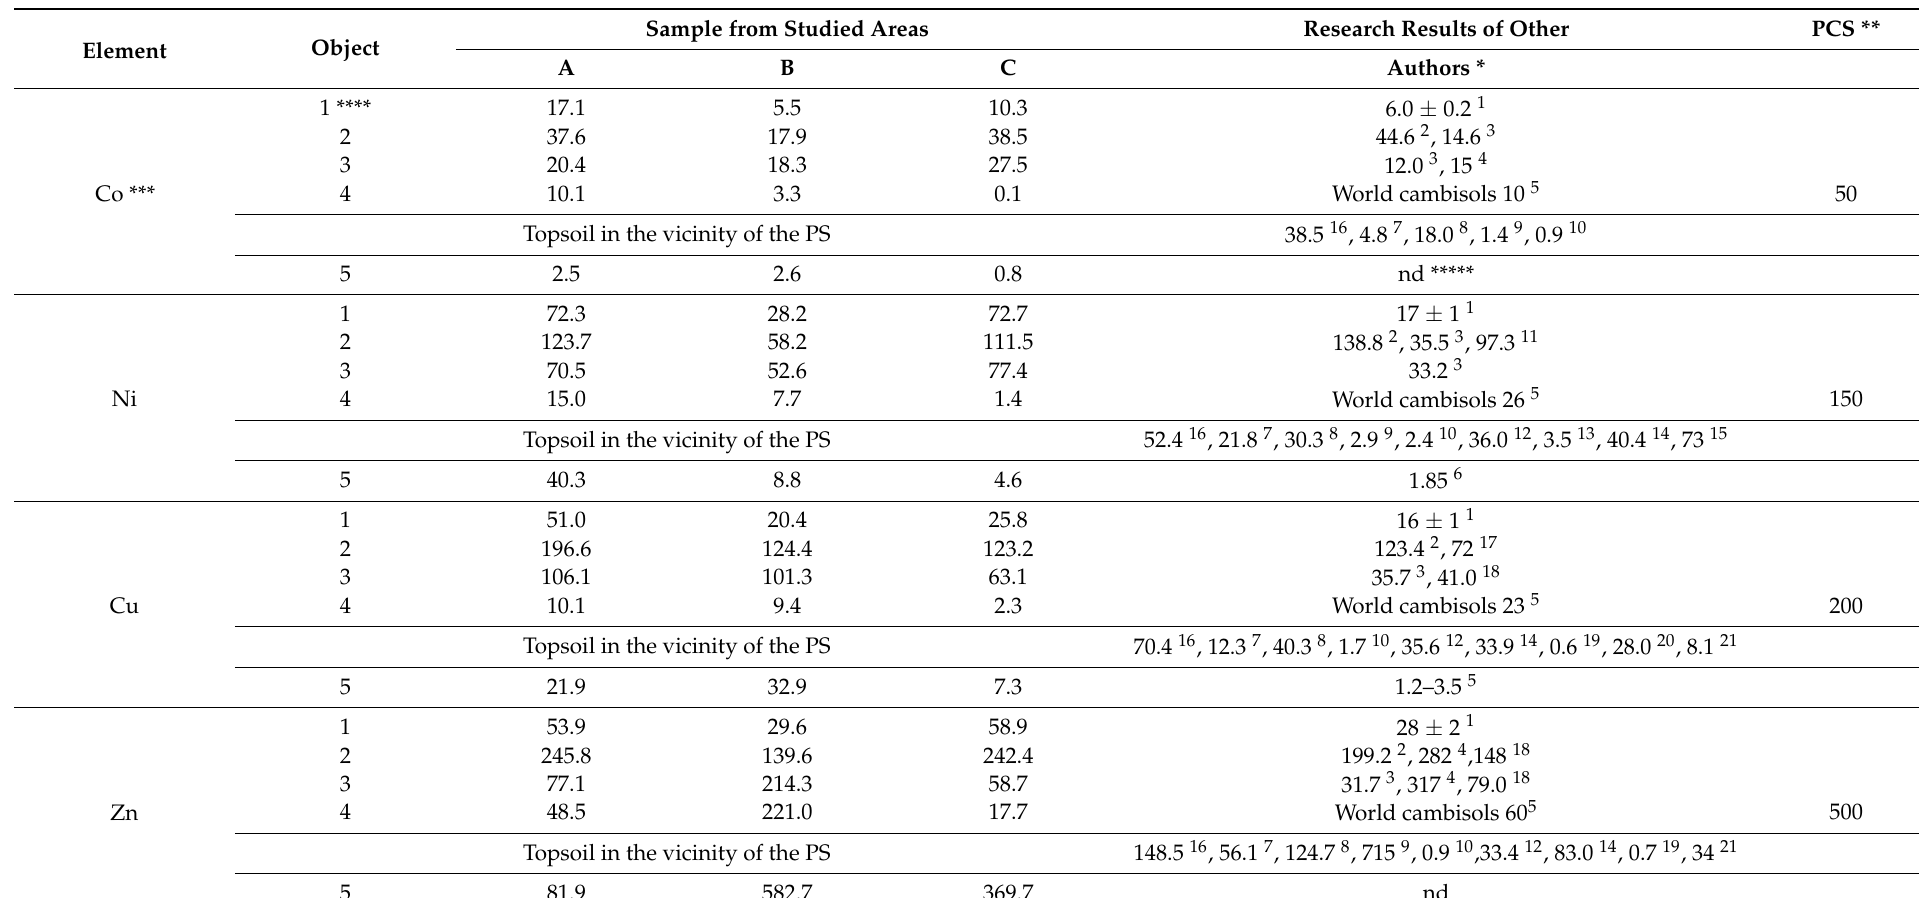
Table 2. Element content (g/Mg or ppm) in studied feed coal, fly ash, slag. soil, and roots, compared to the results of other authors and to the Polish Journal of Laws 2016 item. Sample from Studied Areas Research Results of Other PCS ** Element Object A B C Authors